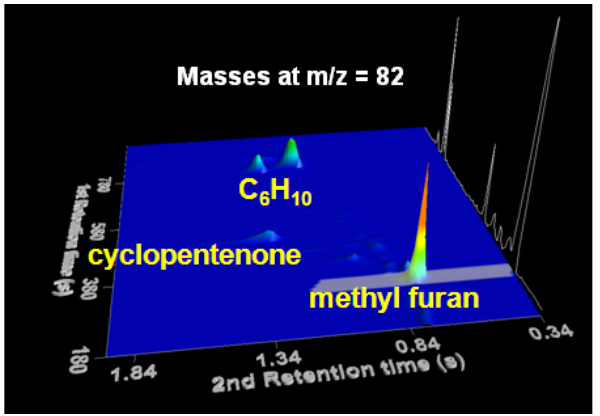
Fig. 3. GC × GC chromatogram of m/z 82. The first and second retention times (s) are plotted against the y- and x-axis respectively. The dominant peak is based on